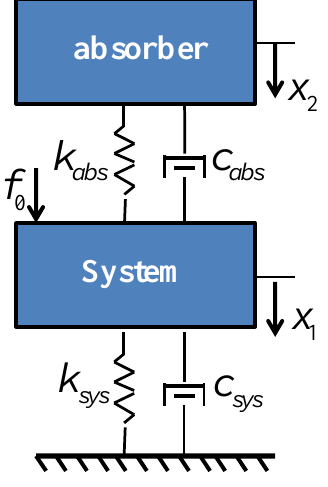
Figure 11. A suspended mass m is maneuvered by the reaction force to reduce displacement x